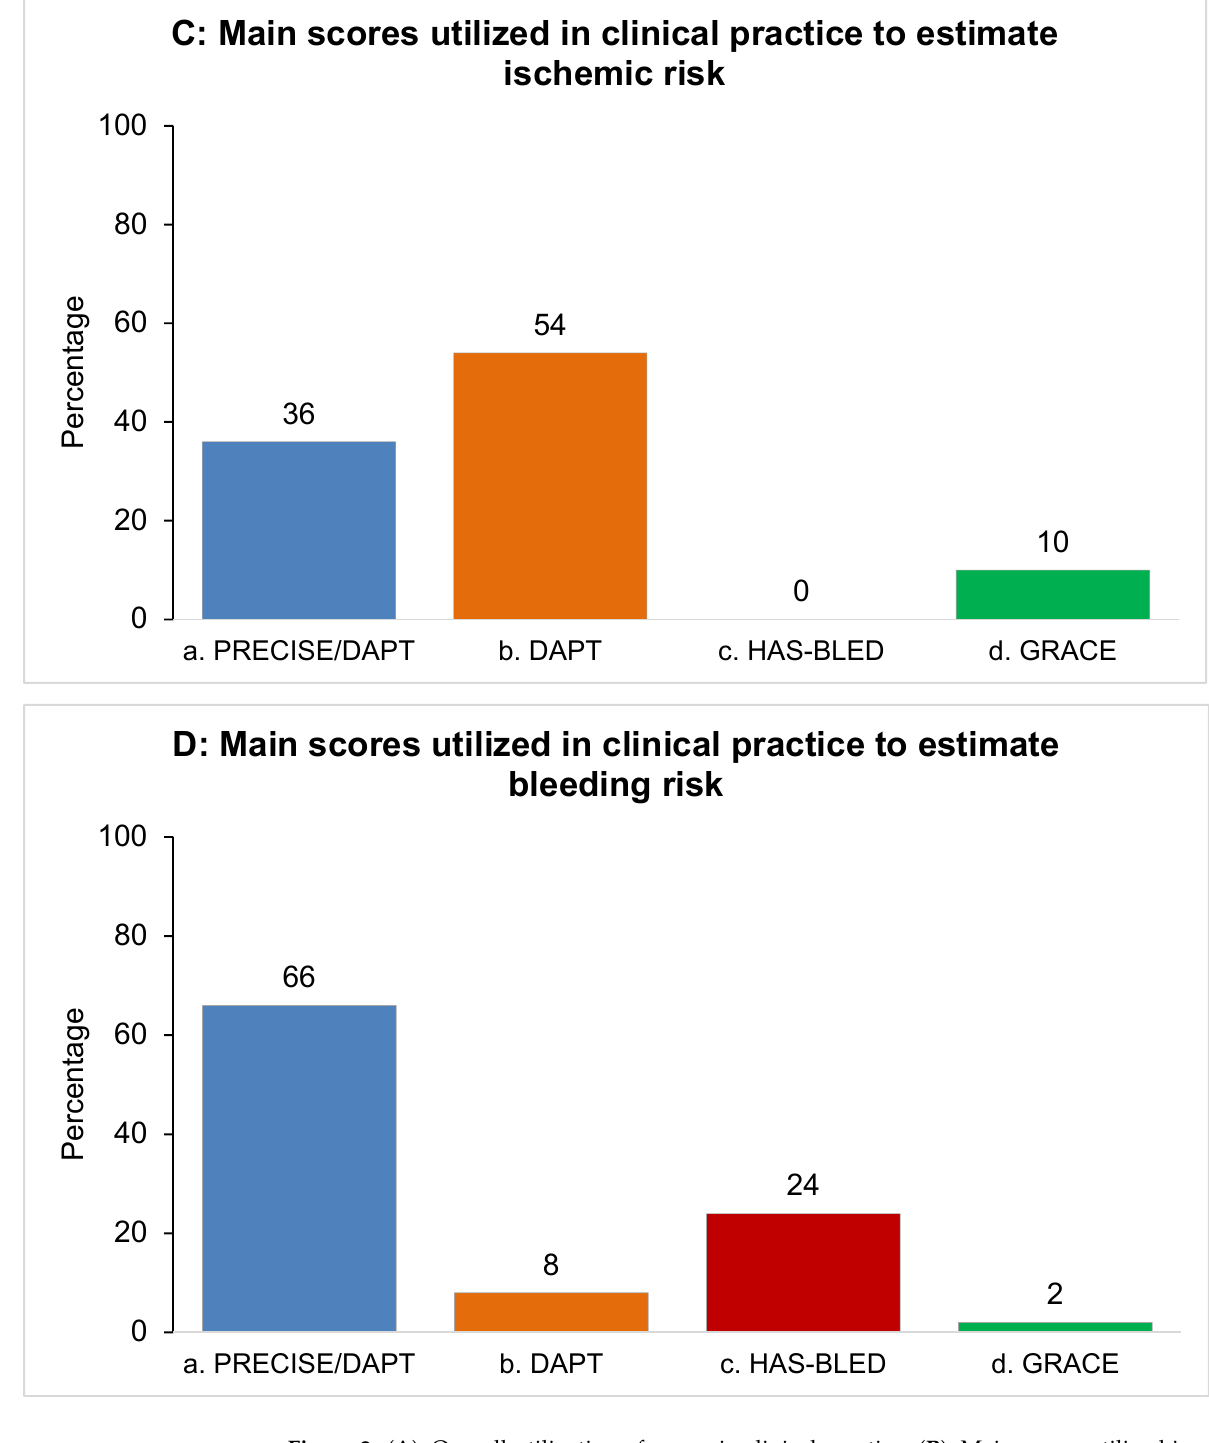
Figure 2. ( A ): Overall utilization of scores in clinical practice. ( B ): Main scores utilized in clinical practice overall. ( C ): Main scores utilized in clinical practice to estimate ischemic risk (%). ( D ): Main scores utilized in clinical practice to estimate bleeding risk (%).